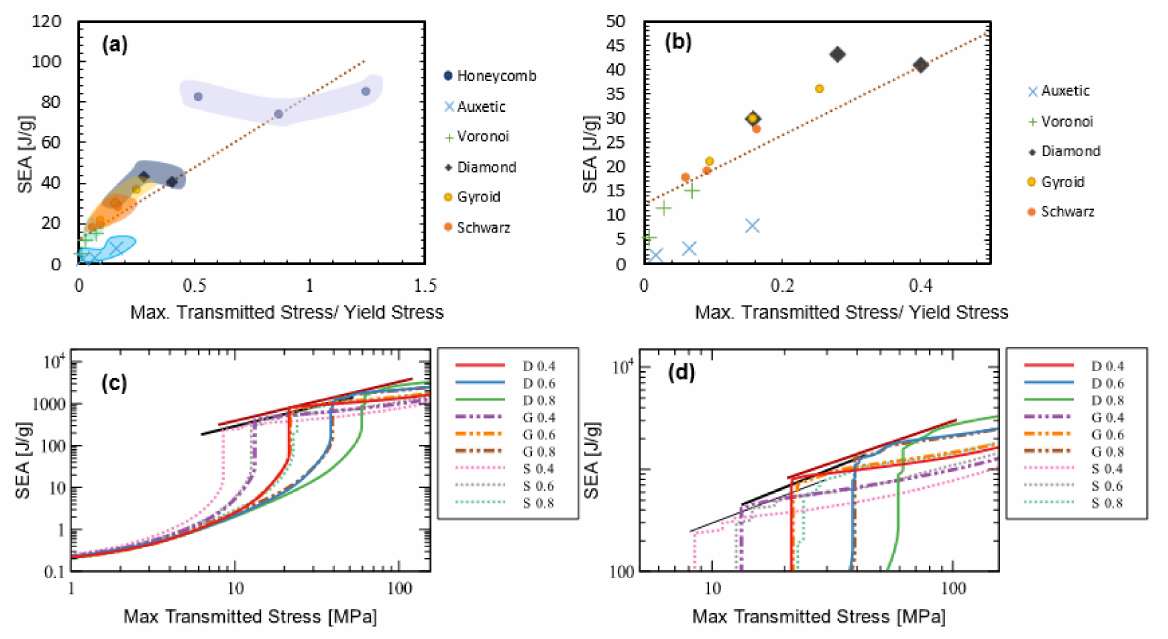
Figure 20. ( a , b ) Comparison of change in specific energy absorption and normalized maximum transmitted stress with relative density for studied structures. ( c , d ) Logarithmic plot of energy absorbed per unit mass against maximum transmitted stress until the structure absorbs that